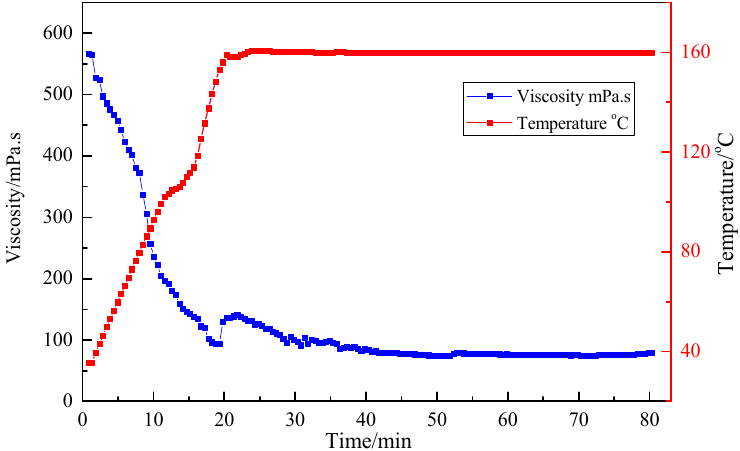
Figure 6. Shear resistance of 5 wt % VES-T with 1.2 wt % NaSal fracturing fluid at 160 °C, 170 s − 1 .